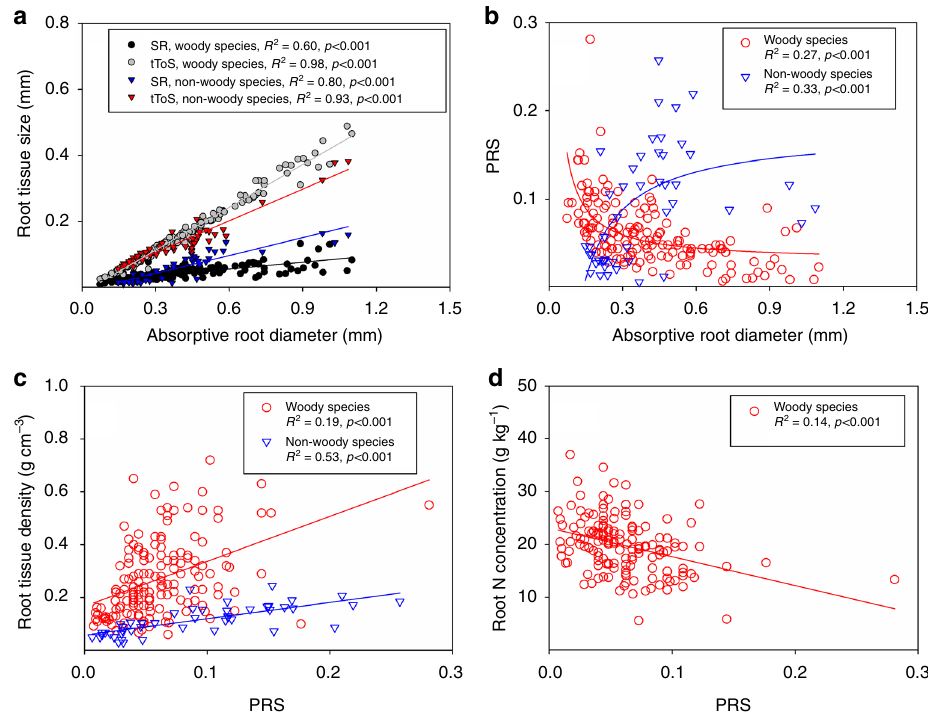
Fig. 1 Allometry in absorptive roots. Allometric relationships between anatomical structures ( a , b ), and the relationships between the proportion of root cross-sectional area occupied by the steles (PRS) with root tissue density and root N concentration ( c , d ) for absorptive roots of woody and non-woody species. SR = stele radius, tToS = thickness of tissues outside the steles. See Supplementary Data 1 for the data sources, and Supplementary Data 2 for the regression equations. The insets show the fi tness of the linear regressions ( a , c , and d ) and allometry-based nonlinear regressions ( b